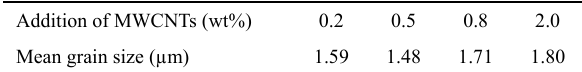
grain size of the cermets Addition of MWCNTs (wt%)